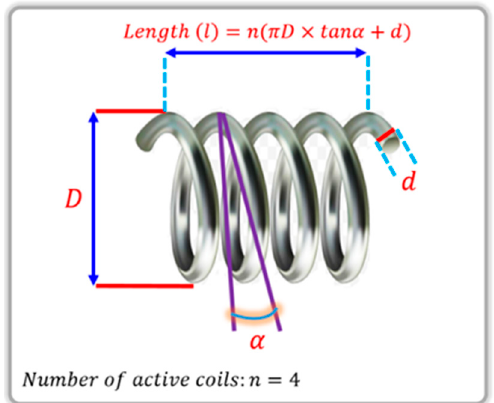
Figure 6. Geometrical design of a NiTi coil spring, representing thickness ( d ), outer diameter ( D ), length ( l ), number of turns in the coil ( n ), and initial pitch angle ( α ); (Designed by G.S.).